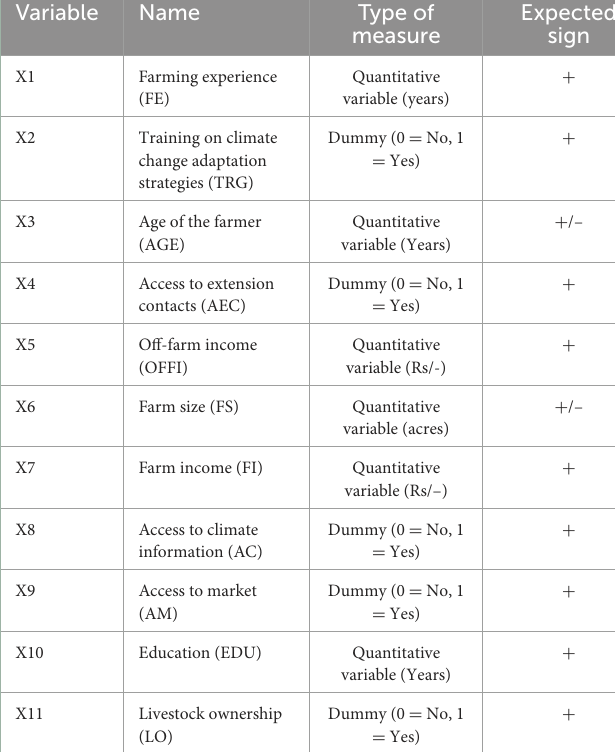
TABLE 3 Description of explanatory variables used in the multinomial logistic model.